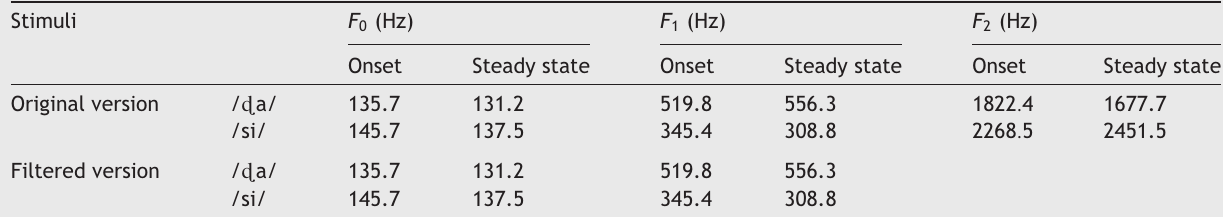
Fundamental frequency and the two formant frequencies (in Hz) at the transition duration of original and filtered version of / (cid:2) a/ and /si/